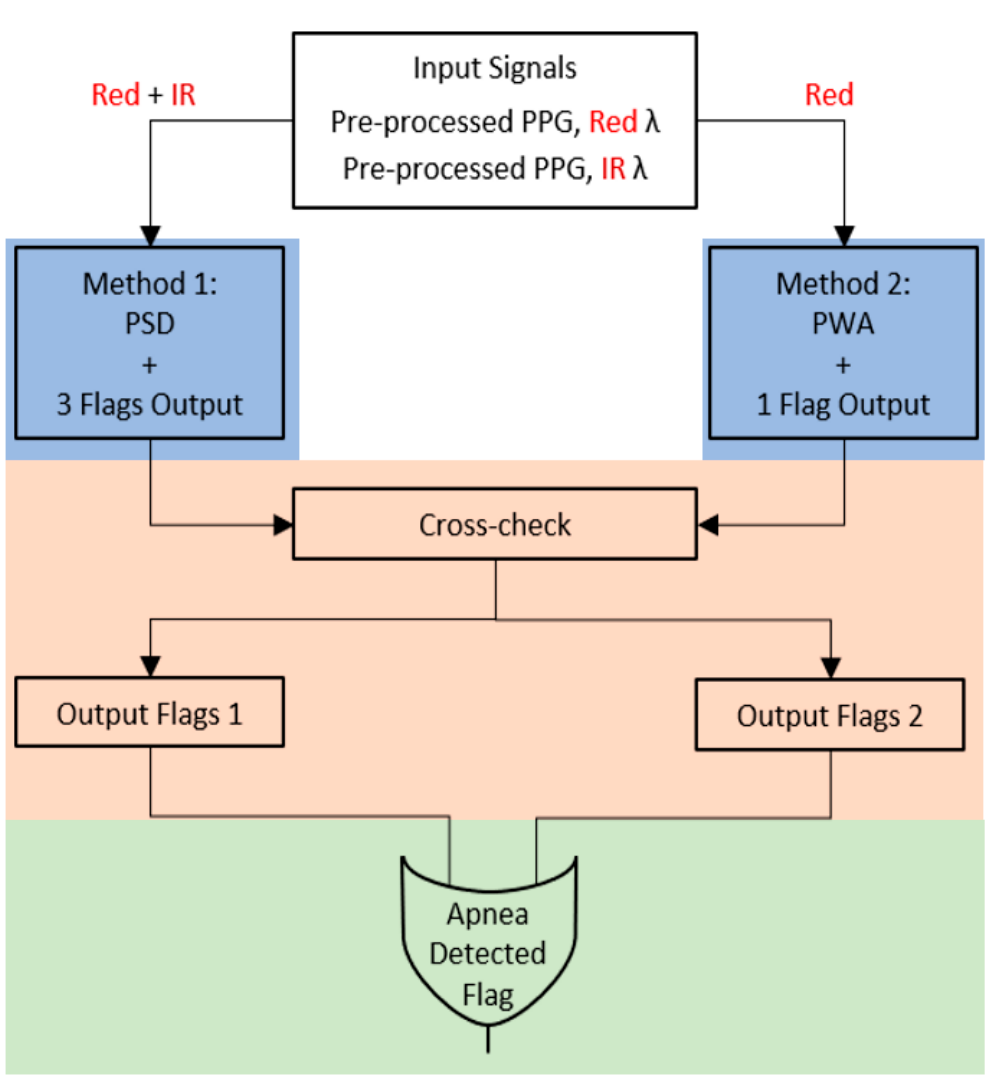
Figure 7. Logic scheme of the apnea detection algorithm. The “flags” are numerical feedbacks that propagate apnea detection results through the different steps of the algorith.